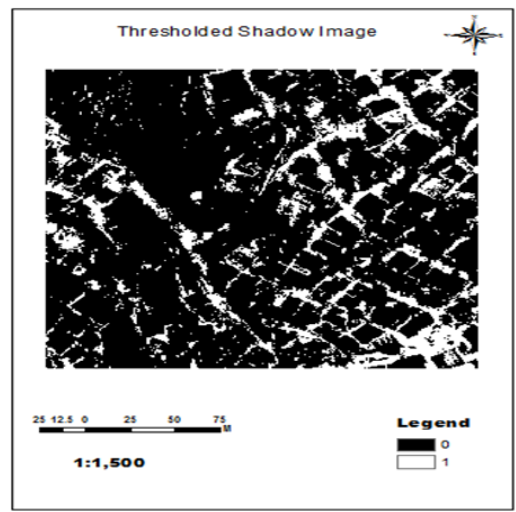
Figure 7. Shadow index image after applying a